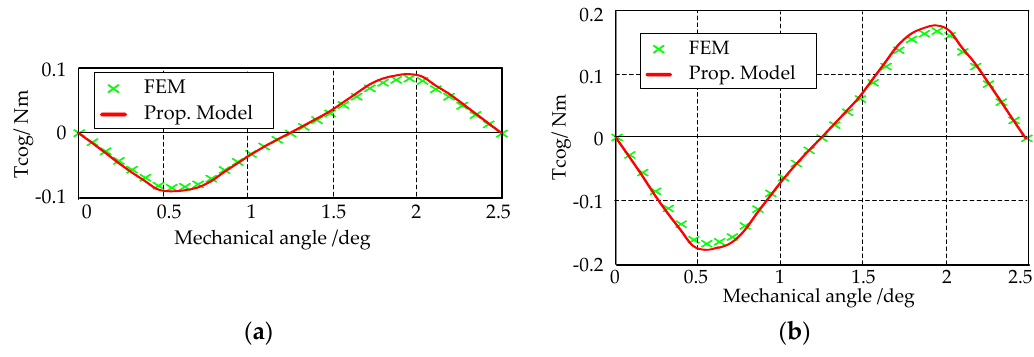
Figure 10. One cycle of cogging torque versus magnet rotor position of the DRRF wind generator: ( a ) Inner cogging torque; ( b ) Outer cogging torque.